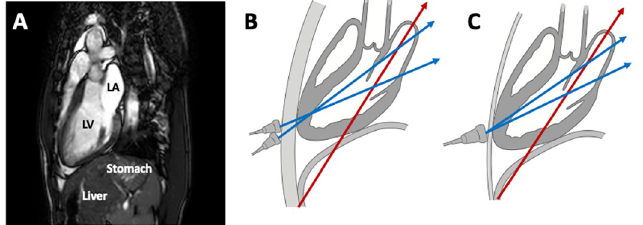
Fig 9. Difficulty in obtaining an optimized LA view. Panel A shows a cardiac magnetic resonance image of the heart and surrounding structures. Panel B shows a subject in whom there is some distance between the chest wall and the heart apex. This is typical of large-bodied westerners. In such cases, there is space on the chest wall to record both the left ventricle and the left atrium (blue arrows). However, the LA long axis runs more caudally (red arrow); thus, it is quite difficult to obtain an optimal LA view. Panel C depicts a subject whose apex is located behind the chest wall. This is typical of slender Japanese subjects. Since the scanning area is limited, only angulation of the transducer enables a different cut-plane of the left atrium. However, it is difficult to make significant changes in long axis delineation of the LA wall. Delineation changes cause subtle changes in both the LA long axis diameter and LA